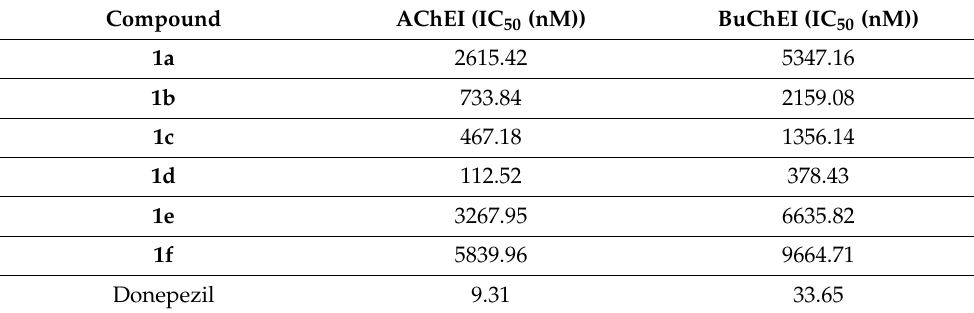
Table 1. In vitro cholinesterase inhibition potential of compounds ( 1a – 1f ).